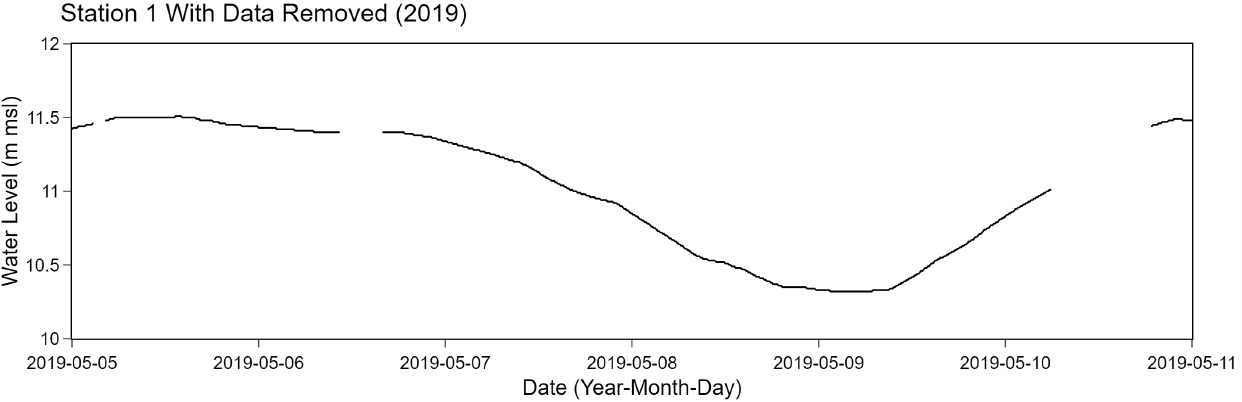
Figure 8. Example of station 1 after removing data points.